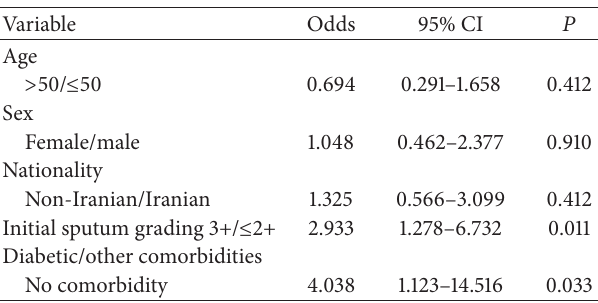
Table 5: Risk estimate of nonconversion of sputum smear at the end of intensive